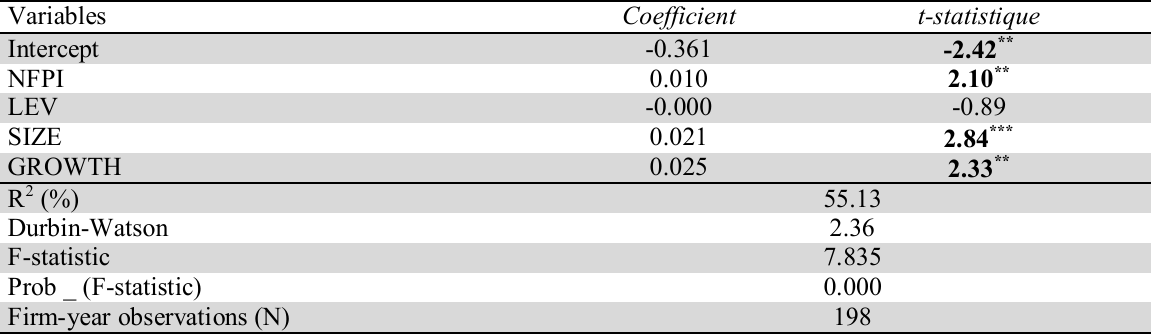
GLS regression model (Eq. (A.2)) with